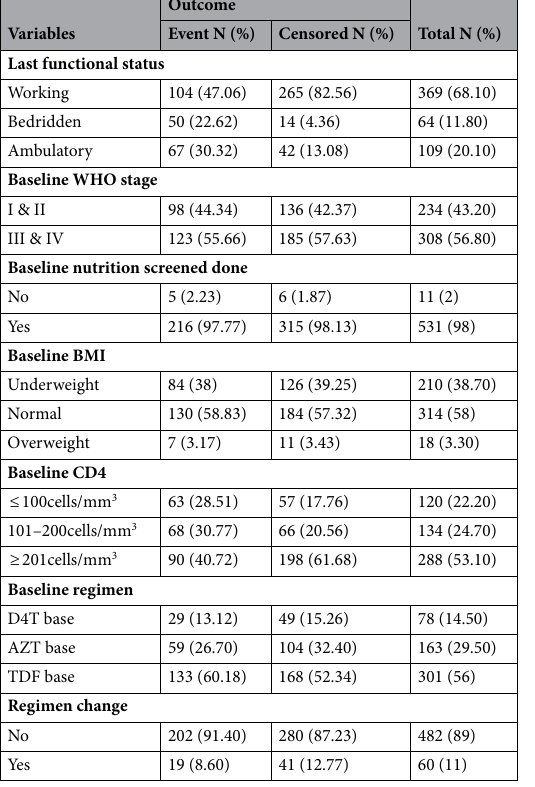
Table 3. Clinical and laboratory characteristic of adult HIV patients in Bichena health center, Amhara, North West, Ethiopia, January 1, 2008–December 30,